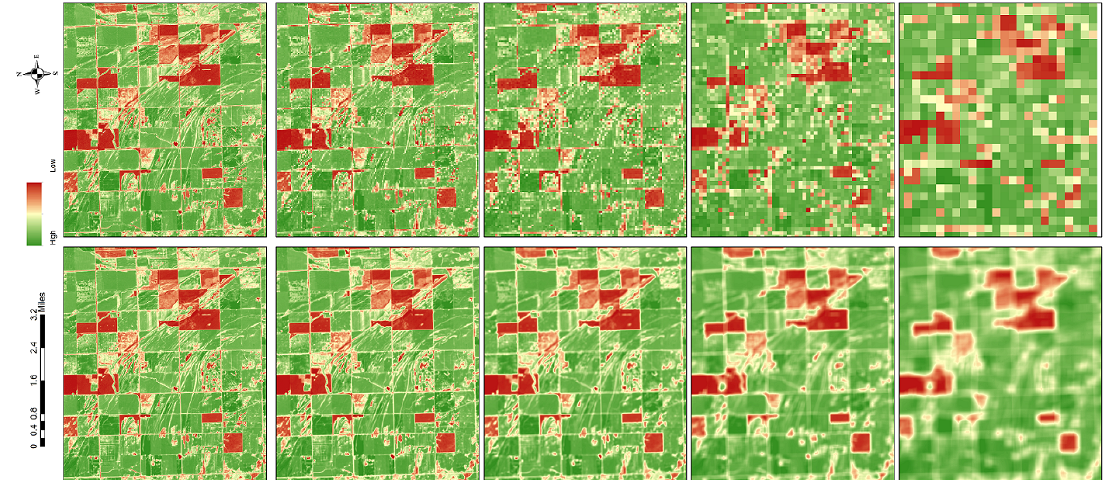
Figure 8. Results from window-based aggregation on NDVI (bottom row) where w = 4, 8, 16, 32 and 64 (left to right). Results from resampling in ArcGIS (top row) for w = 3, 9, 15, 30 and 63 (left to